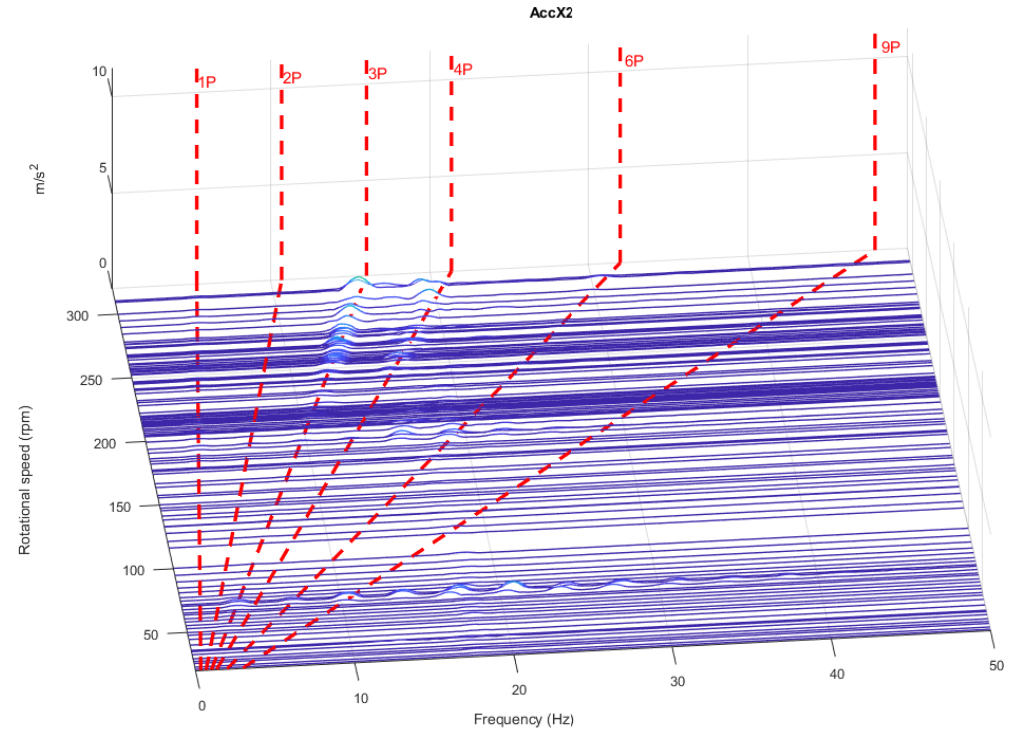
Figure 9. Waterplot of accelerations in x direction on layer 2.